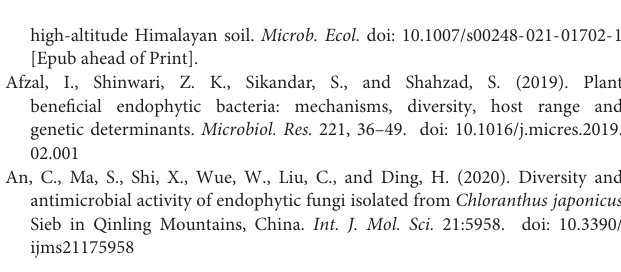
Supplementary Table 3 | PGP traits of bacterial endophytes screened using plate-based assays. Supplementary Table 4 | PGP traits of fungal endophytes screened using plate-based